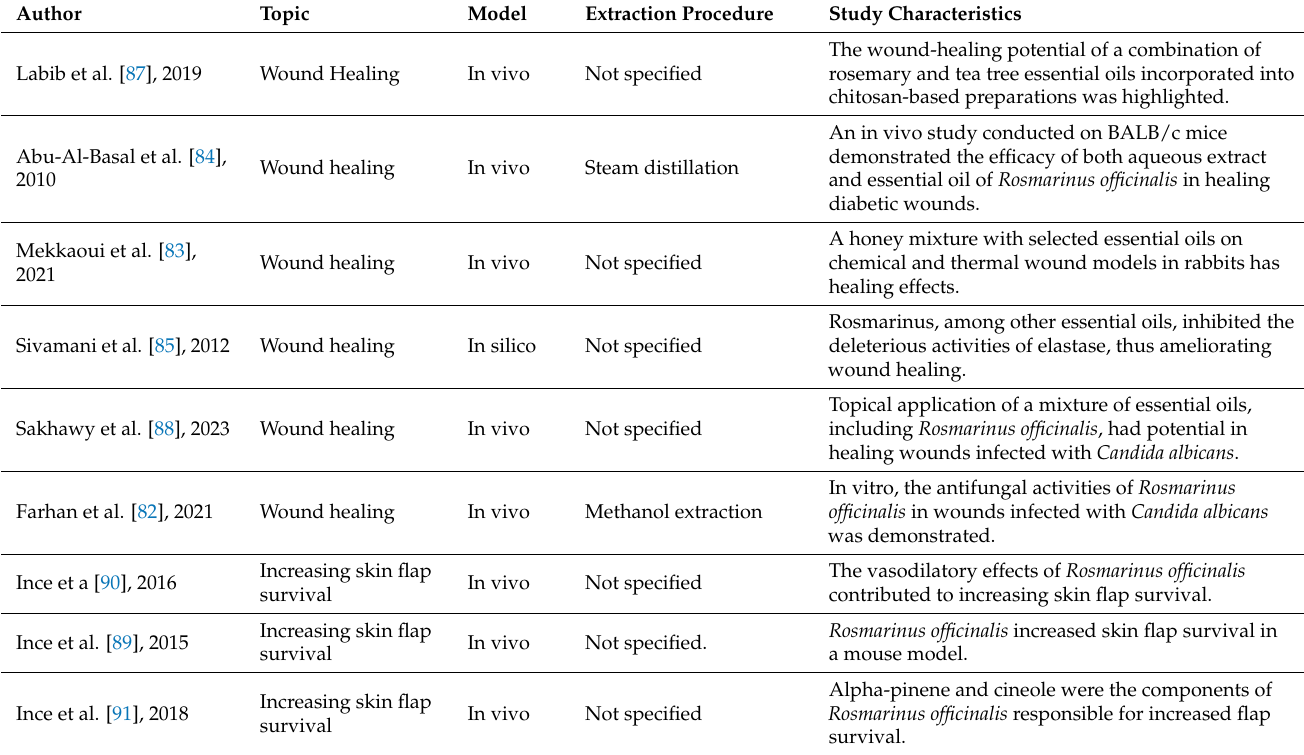
Table 3. The role of R. officinalis in wound healing and skin flap